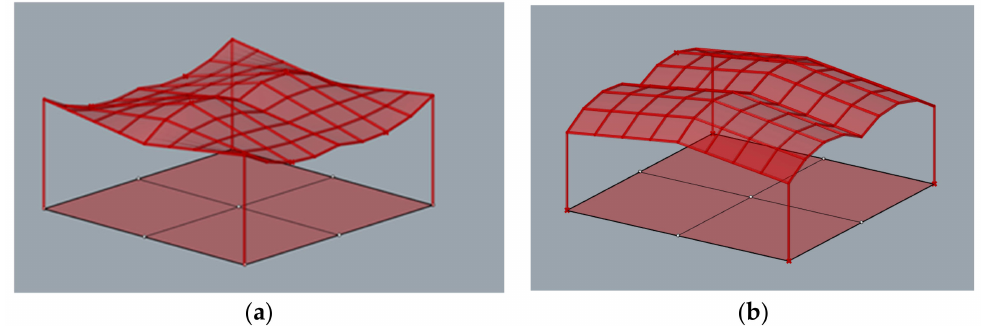
Figure 9. The structures with the possibility of using flat panels: ( a ) a cylindroid structure 1; ( b ) a cylindroid structure